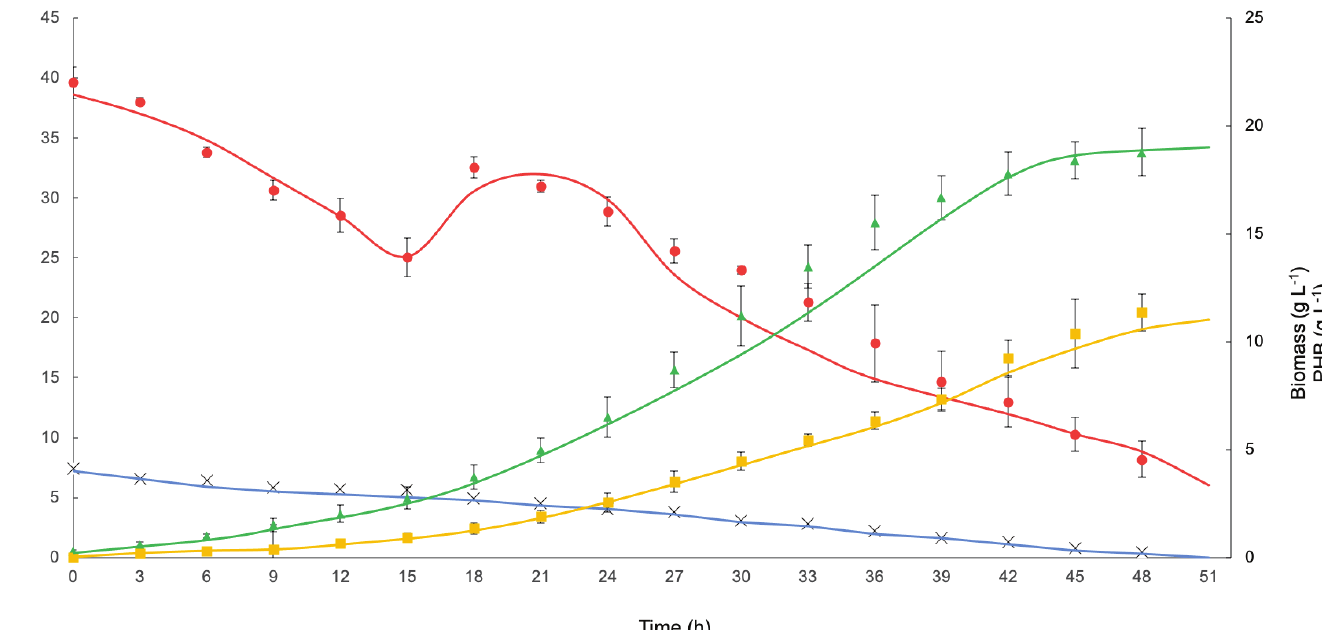
Fig. 5 – Model-based fed-batch cultivation at constant feed rate. Comparison between model predictions (smooth lines) and exper- imental values (data points) (0–15 h-batch; 15–35 h fed-batch at constant feed rate of 100 mL h –1 ; 35–48 h-batch fermen- tation). Data points (● Glycerol, × Nitrogen, ■ PHB, ▲ Biomass) represent the average values of the samples